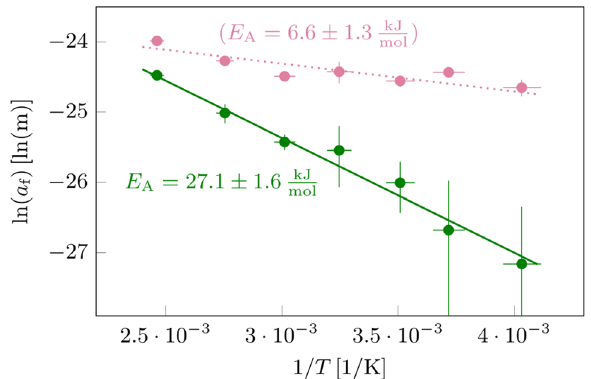
Figure 4. Arrhenius Plots of the ESM data recorded for a single grain (see Fig. 3): (Green) Frequency- dependent Vegard strain parameter a f plotted vs. the inverse temperature. (Red) Average LF amplitude A LF plotted vs. the inverse temperature. In both cases, the slope represents an activation energy barrier E A for ambipolar diffusion with quantitative values as indicated in the figure. Please note that the temperature- dependent analysis of A LF does not result in a meaningful energy barrier for ambipolar diffusion, but was rather added to highlight the problems, that can arise from temperature independent contributions, which significantly reduce the